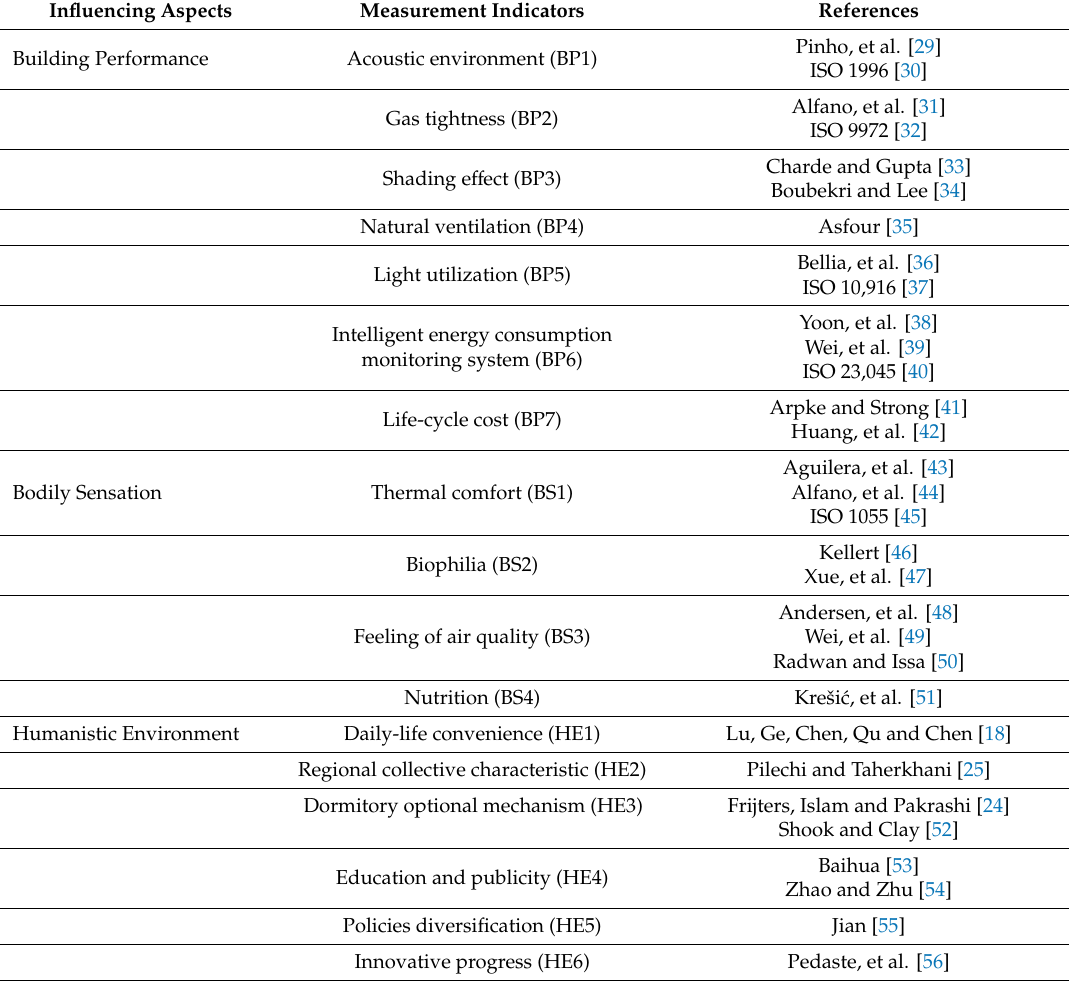
Table 1. Measurement